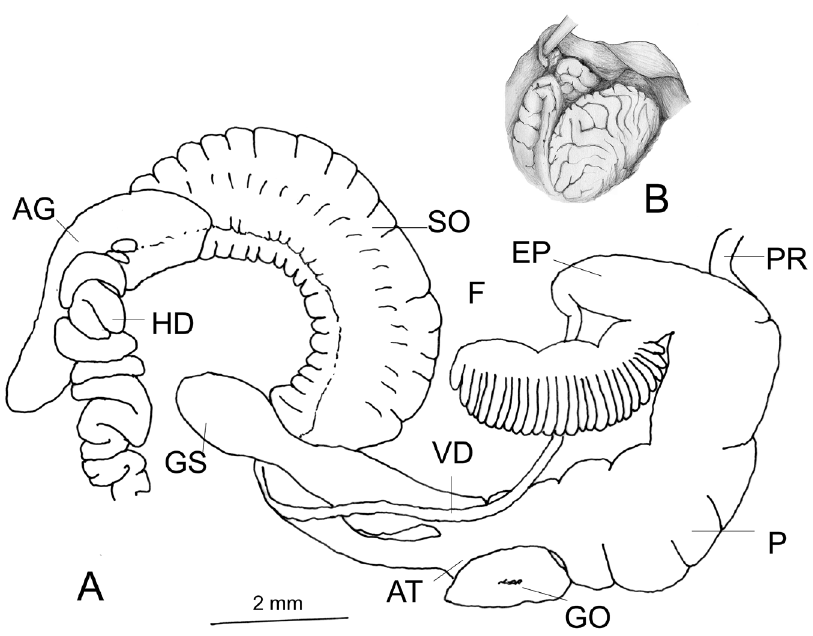
Figure 5. Genitalia of G. tamakoshi sp. n., holotype: CDZMTU057P, A General view B Interior of penis of the same, Suridobhan, left bank of Tamakoshi River, Dolakha District, Central